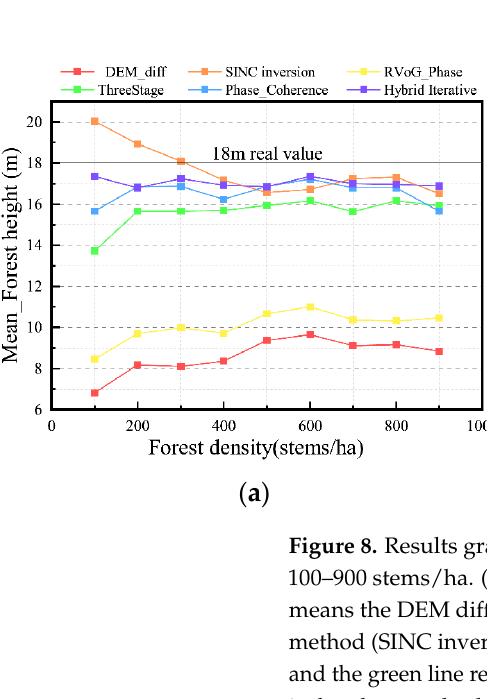
sparsely vegetated areas with forest density below 400 stems/ha. The inversion error de ‐ creased once the forest density exceeded 400 stems/ha, but the RMSE was consistently greater than 1/3 of the actual tree height. Figure 9 displayed the relative height of the DEM difference method and RVoG ground phase method, respectively. The canopy phase cen ‐ ter gradually moved toward the top of the canopy, and the ground phase center also slowly increased. The HV phase center improvement rate was higher than HH ‐ VV polar ‐ ization in 100 ‐ 300 stems/ha, and the inversion accuracy was gradually improved. How ‐ ever, when the stand density exceeds 600 stems/ha, the forest gap area decreases, and the canopy phase center no longer increases at this point. The HV and HH ‐ VV polarization phase center heights are also slowly saturated at this point. As a result, the DEM differen ‐ tial method and RVoG ground phase method are subsequently saturated. It also sug ‐ gested that in sparsely vegetated regions, the canopy phase and ground phase separations represented by HV polarization and HH ‐ VV polarization practically fail, significantly im ‐ pacting the algorithm ʹ s performance.